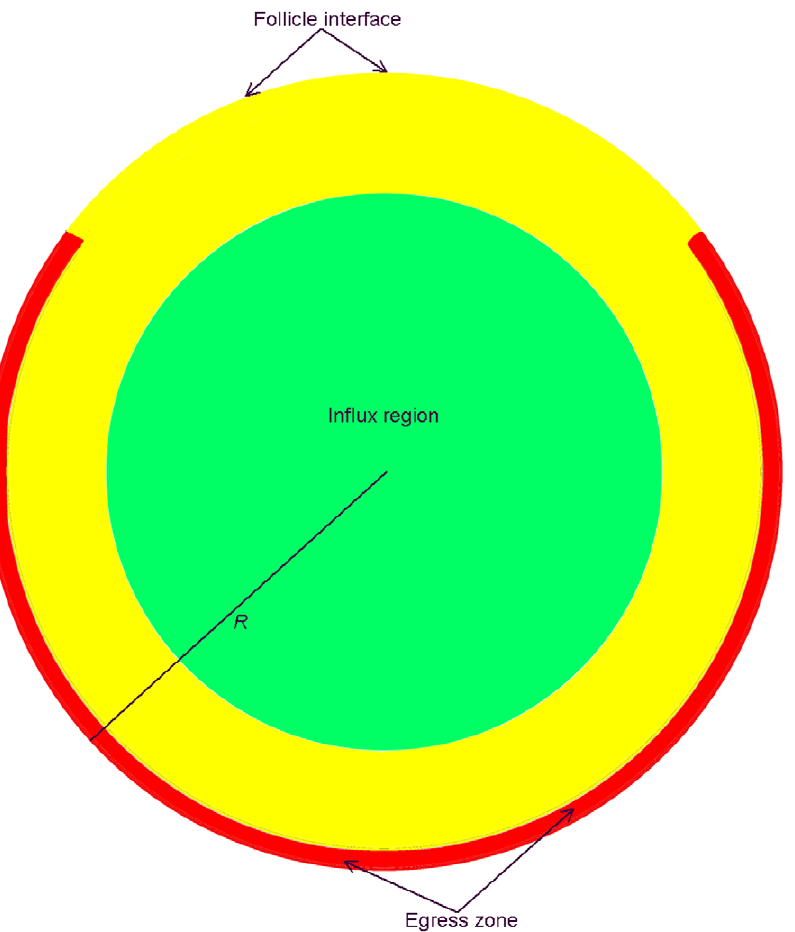
Figure 1. Regions of the spherical ‘‘blob’’ representing the paracortical T zone. T cells enter at random locations within a sphere of radius 0.7 R (green). Exit portals are located within a layer near the boundary (red), except for a ‘‘cap’’ representing the interface with the B cell follicle.